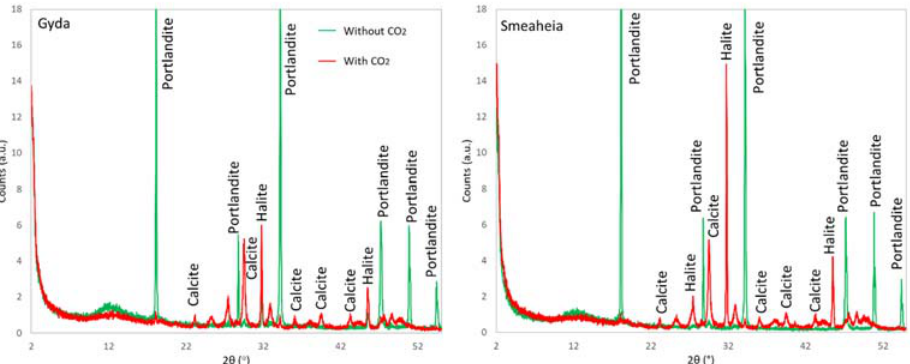
Figure 5. XRD patterns of material deposited at the cathode surface exposed to Gyda and Smeaheia formation water and polarized at 5 V for 30 min. The green and red patterns refer to formation water without and with additional CO 2 , respectively.